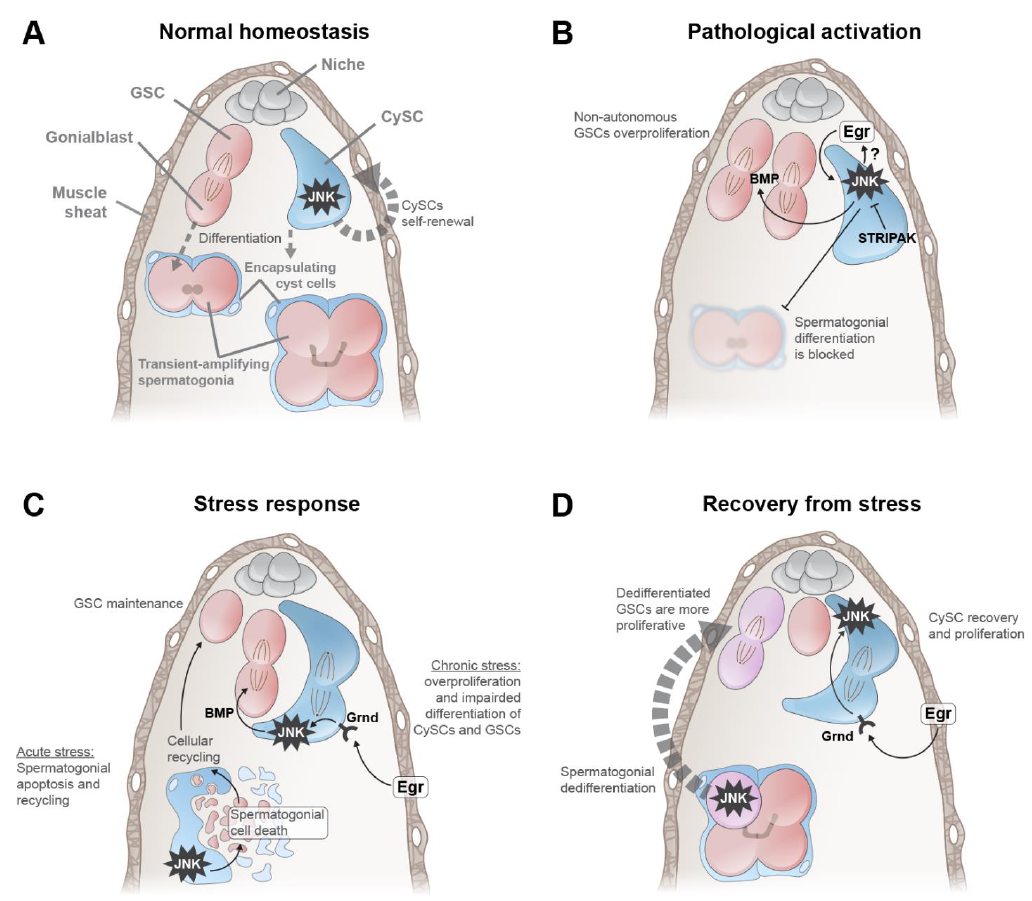
Figure 2. Roles of the JNK pathway in the Drosophila testis. ( A ) Normal homeostasis. The testis is surrounded by a sheath of smooth muscle cells (brown). Niche cells (gray) are anchored to the muscle sheath and secrete self-renewal factors for GSCs (red) and CySCs (blue). A GSC divides asymmetrically to produce a GSC daughter and a differentiating daughter (termed the Gonialblast (Gb)), which undergoes transit-amplifying divisions, producing spermatogonia. A CySC divides to produce cyst cells that become quiescent and encapsulate spermatogonia and remain attached to germ cells throughout their differentiation into spermatids. During homeostasis, JNK is intrinsically activated in CySCs and promotes their self-renewal. ( B ) Pathological activation. Impairment of the STRIPAK complex or the endocytic pathway strongly induces JNK in somatic cells, which produce abnormally high levels of Dpp/BMP. Sustained secretion of Dpp/BMP into the testis lumen causes hyper-proliferation of GSCs and early spermatogonia, while concomitantly blocking spermatogonial differentiation. These effects are genetically dependent on Egr/TNF α , which is likely produced by CySCs and then acts in an autocrine manner. ( C ) Stress response. During acute stress (left), somatic JNK activity causes the non-autonomous death of spermatogonial cells, and these somatic cells endocytose and recycle the debris of the dying germ cells. This recycling is necessary for maintaining the GSC pool during stress, presumably because recycled cellular components are somehow provided to GSCs. Under chronic stress (right), the muscle sheath secretes Egr/TNF α , which is transduced by CySCs through Grnd/TNFR. This JNK activity causes hyper-proliferation of CySCs. JNK-activated CySCs secrete Dpp/BMP, which strongly induces GSC proliferation. ( D ) Recovery from stress. Upon termination of starvation (left), JNK autonomous activation in one or more cells in a spermatogonium (pink cell with starred JNK) induces dedifferentiation into GSCs. This dedifferentiated GSC (pink dividing cells at niche) is more proliferative than the wild-type (i.e., non-dedifferentiated) sibling GSC (red cell at niche). Additionally, upon termination of starvation (right), Egr/TNF α is secreted by the muscle sheath cells and is transduced by CySCs through Grnd/TNFR. JNK-activated CySCs increase their proliferation, which facilitates the quick recovery of the CySC